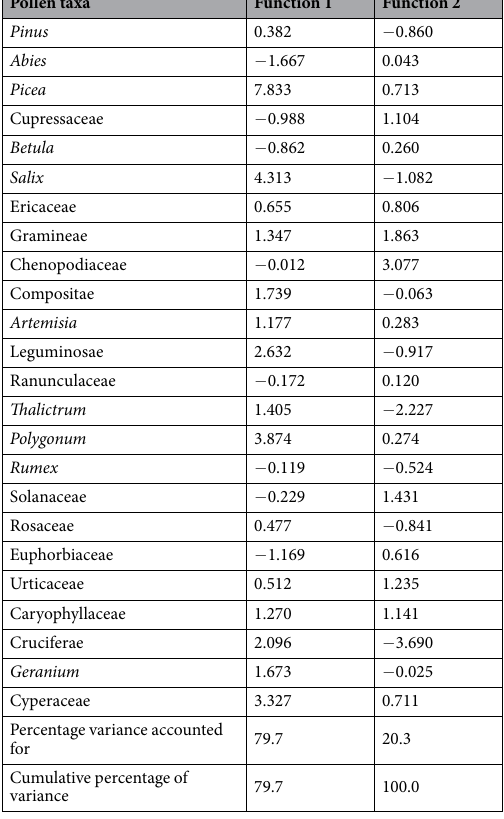
Table 1. Coefficients in discriminant function of the 24 pollen taxa.